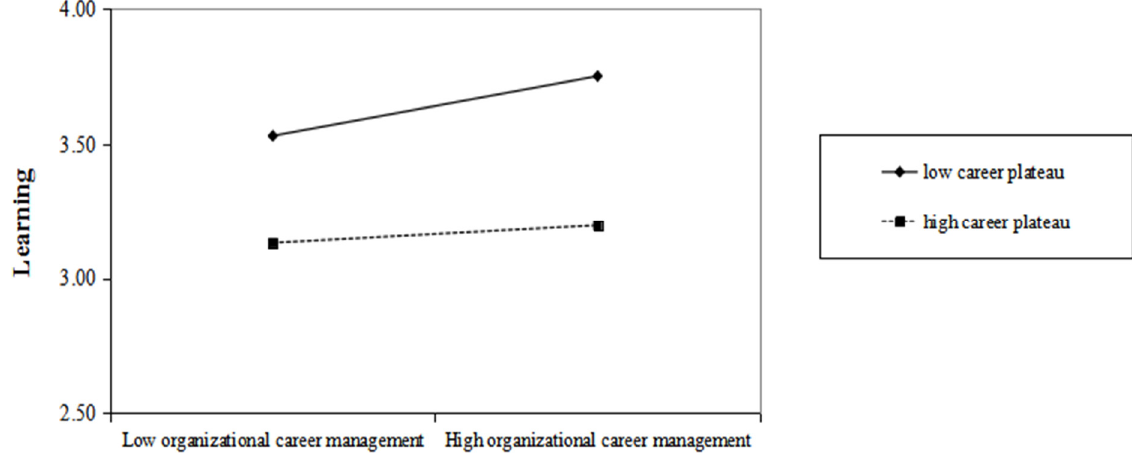
Figure 2. Moderating role of career plateau on organizational career management and employee learning.